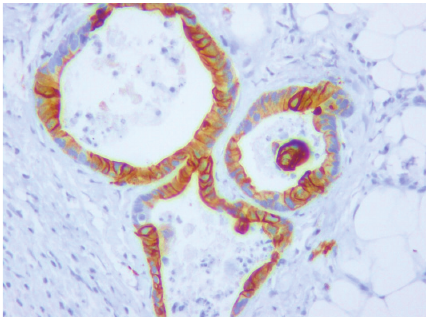
Figure 8: CDX-2 immunostaining in both cases shows intense pos- itivity in nucleus of neoplastic colonic glands (200x magnification).